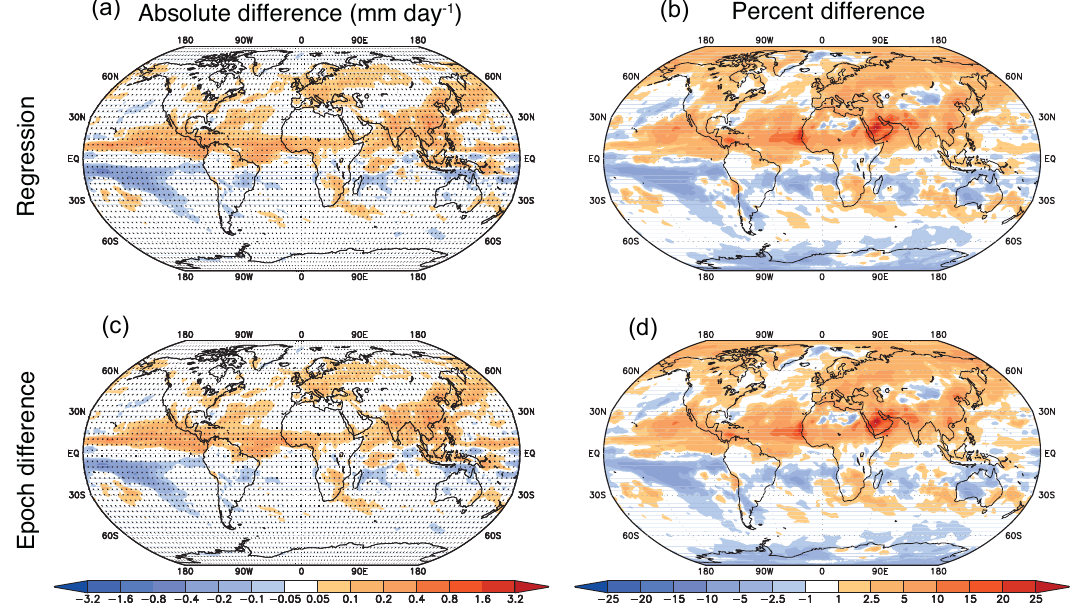
¯ T ¯ T + P RCP8 . 5 , nonCO 2 (116–140) 1pctCO2 (cid:49) RCP8 . 5 , CO 2 (116–140), and results are shown 2 (cid:49)